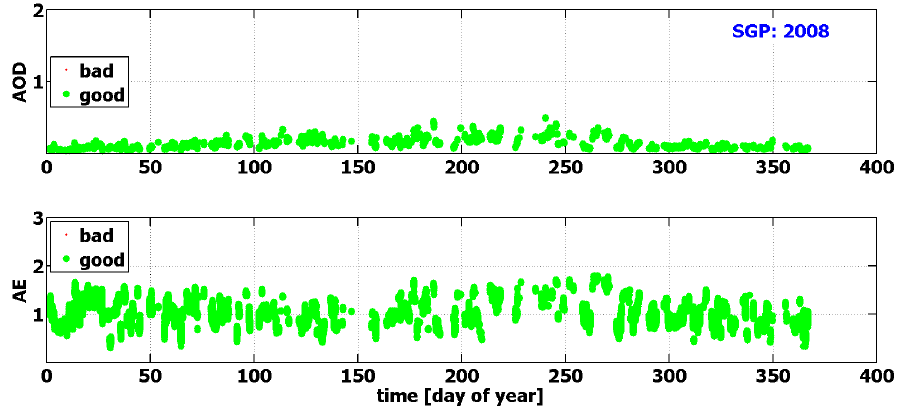
Figure 8. Examples of the (PDFs) of AODs (at 0.5 μ m) retrieved at the ARM SGP site